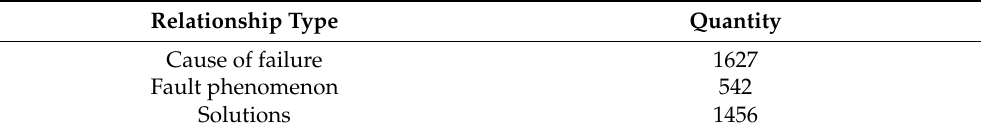
Table 8. Relationship type and quantity.